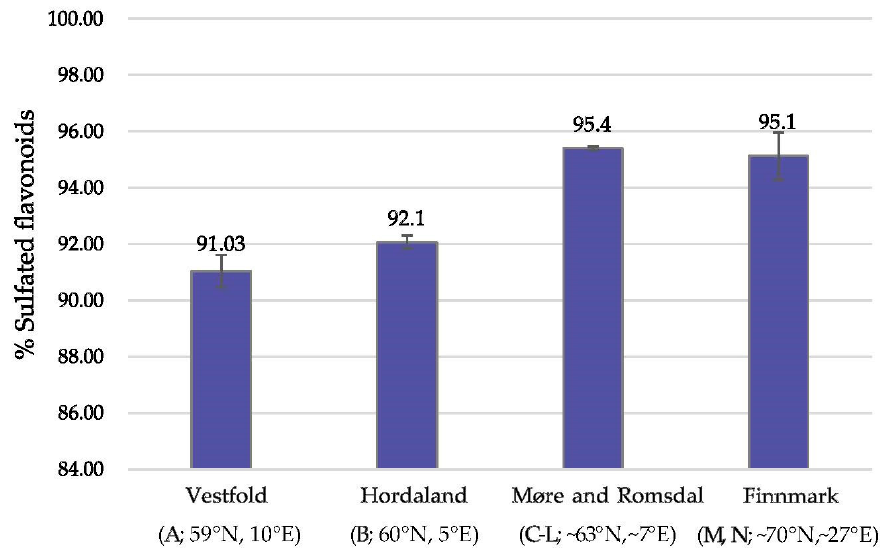
Figure 3. Relative sulfated flavonoid content (%) ( 1 , 2 , 4 , 7 , 9 , 10 , Figure 1) found in Zostera marina leaves collected from localities in different regions (Vestfold, Hordaland, Møre and Romsdal, Finnmark, see Section 4.1) in Norway.